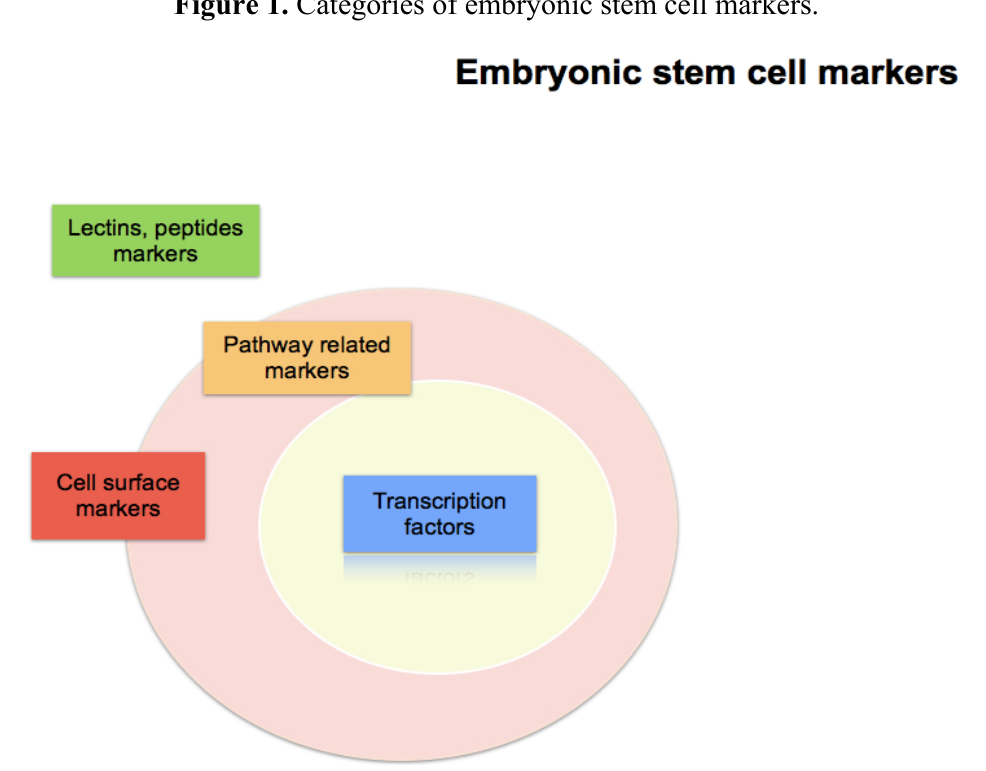
Figure 1. Categories of embryonic stem cell